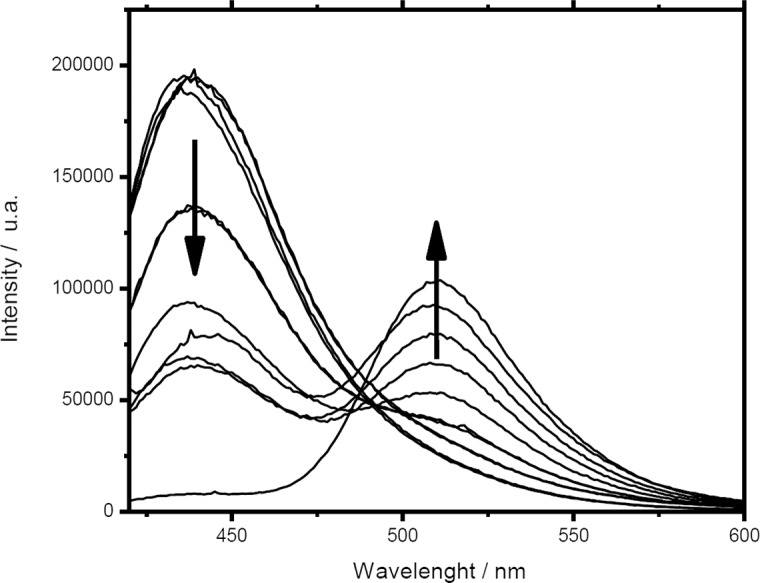
Emission spectra of Pyranine included in the pool of MPS/CHCl3 reversed micelles with increasing amounts of water.Arrows indicate the effect observed upon water increase.